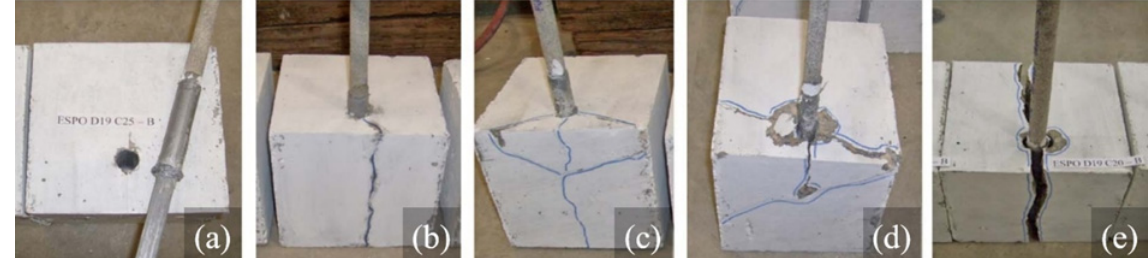
Figure 6. Bond failure types ( a ) pure pullout; ( b ) conventional concrete cover; ( c ) V-shaped concrete cover; ( d ) diagonal concrete cover; ( e ) concrete block split [71].